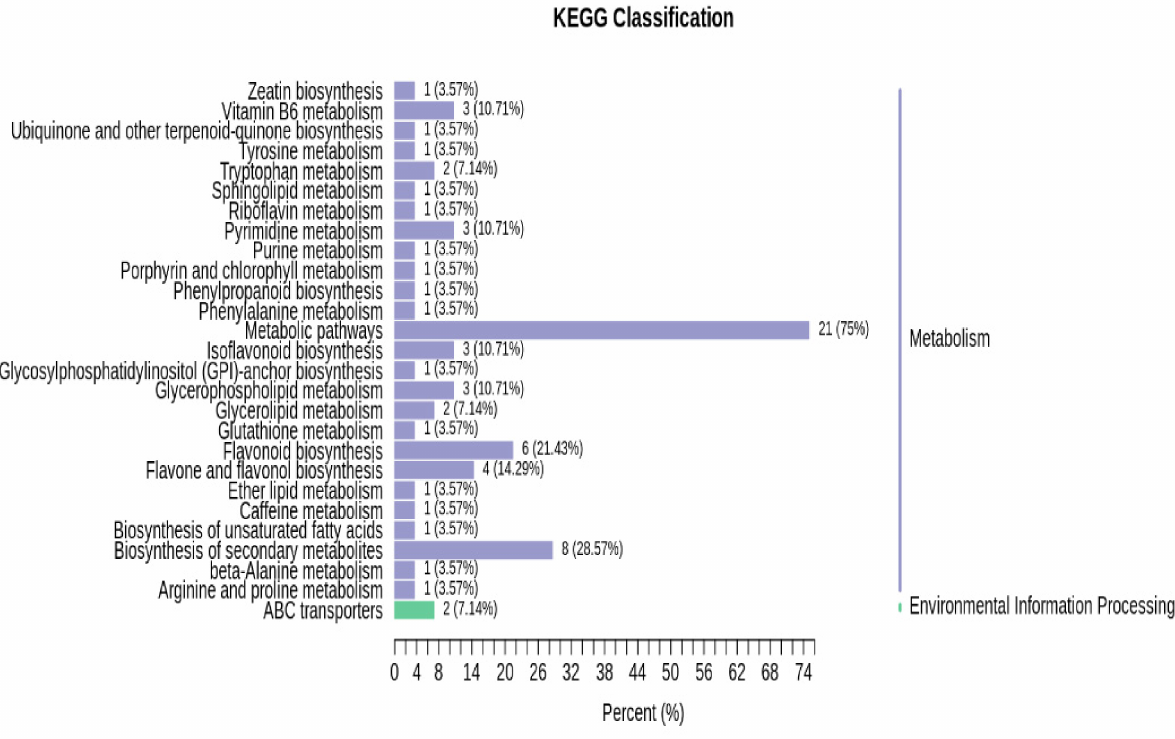
Figure 9. The KEGG classification of differential